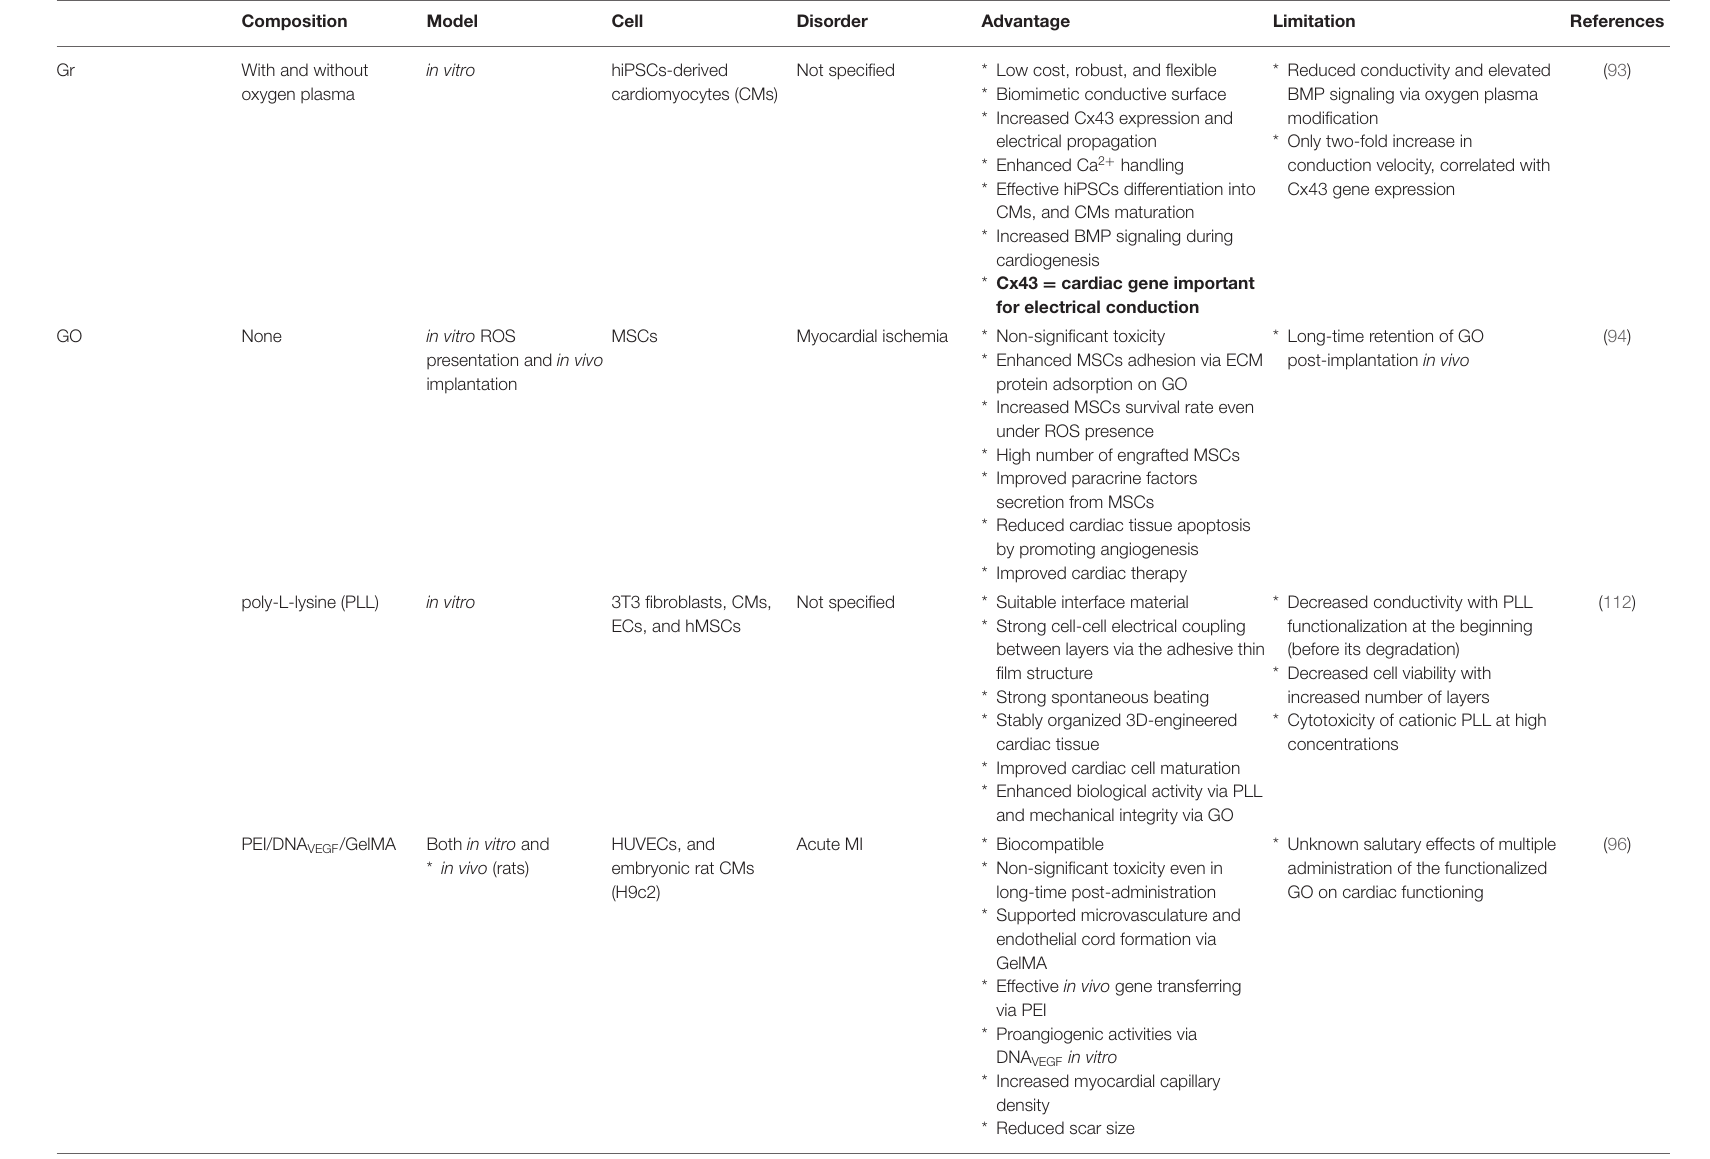
TABLE 1 | 2D material-based studies in cardiovascular tissue